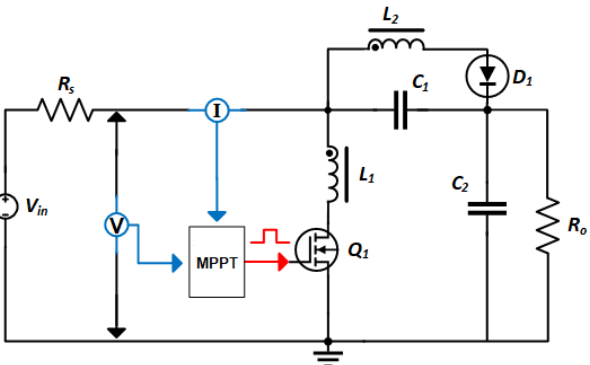
Figure 9. Schematic diagram of the converter used to evaluate the proposed MPPT